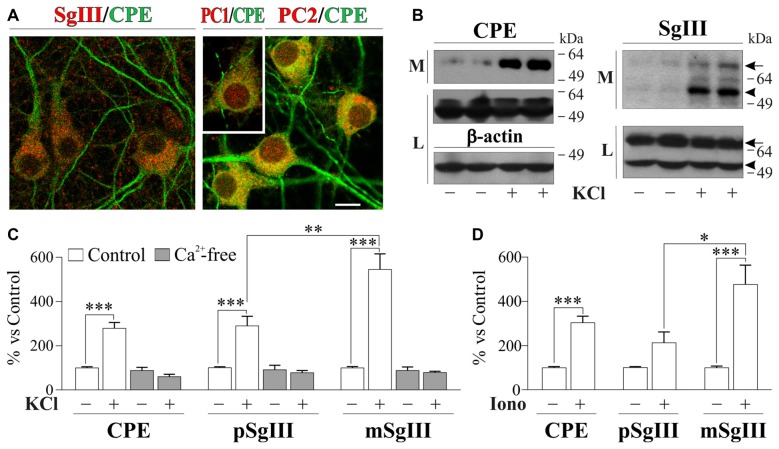
Cellular distribution and release of CPE and SgIII in cultured neurons of the cerebral cortex. (A) Confocal immunofluorescence shows a prominent dendritic location for CPE (green) in pyramidal- and stellate-shaped neurons, while SgIII (red, left) is found in cell bodies and axon-like processes. No apparent colocalization was observed for the 2 proteins. Abundant signal shows the presence of the PC1/3 (red, inset) and PC2 (red, right) in the cultured neurons, with a broad somatic distribution. Scale bar in μm: 10. (B) Western blots show a very low basal secretion for CPE and SgIII, which were abundantly released in response to depolarization by KCl 55 mM for 15 min. Both forms of SgIII (arrow: proform, p and arrowhead: mature, m) were found in the extracellular media (M). No changes were found at intracellular levels in the lysate fraction (L). β-actin was used as loading control. (C) Release in response to KCl-depolarization was significant for CPE and both p- and mSgIII, the latter being especially high. In all cases, evoked secretion was abolished in absence of Ca2+, showing a Ca2+ dependance. (D) 1 μM Ionomycin was used to trigger the CPE and SgIII release. Graphs show the percent variation compared with controls and are presented as the mean ± SEM normalized by intracellular levels of β-actin. *p < 0.05; **p < 0.01; ***p < 0.001, Mann-Whitney test.